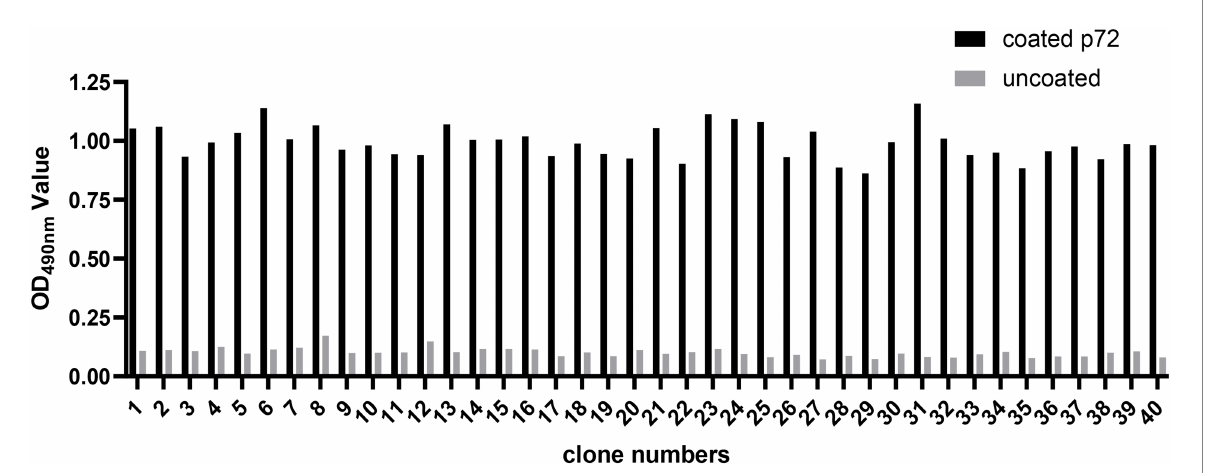
FIGURE 1 Identification of ASFV p72 protein binding phages by monoclonal phage ELISA. Forty clones selected from final round bio-panning were detected, and all of them were identified as positive. The clone was regarded as positive if the absorbance in the antigen-coated well was at least threefold greater than that in uncoated